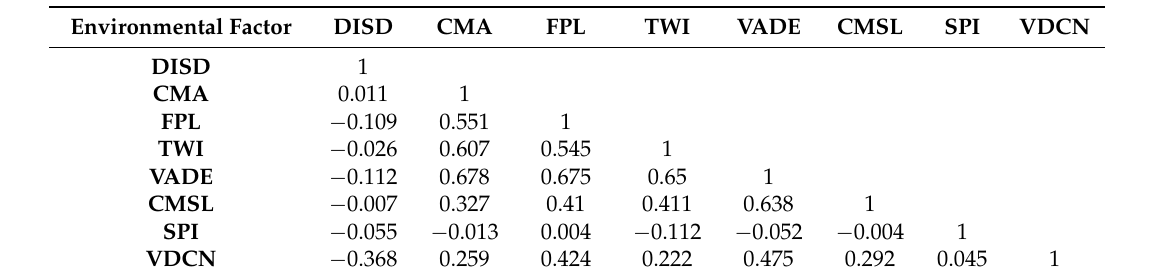
Table 6. Correlations of hydrological